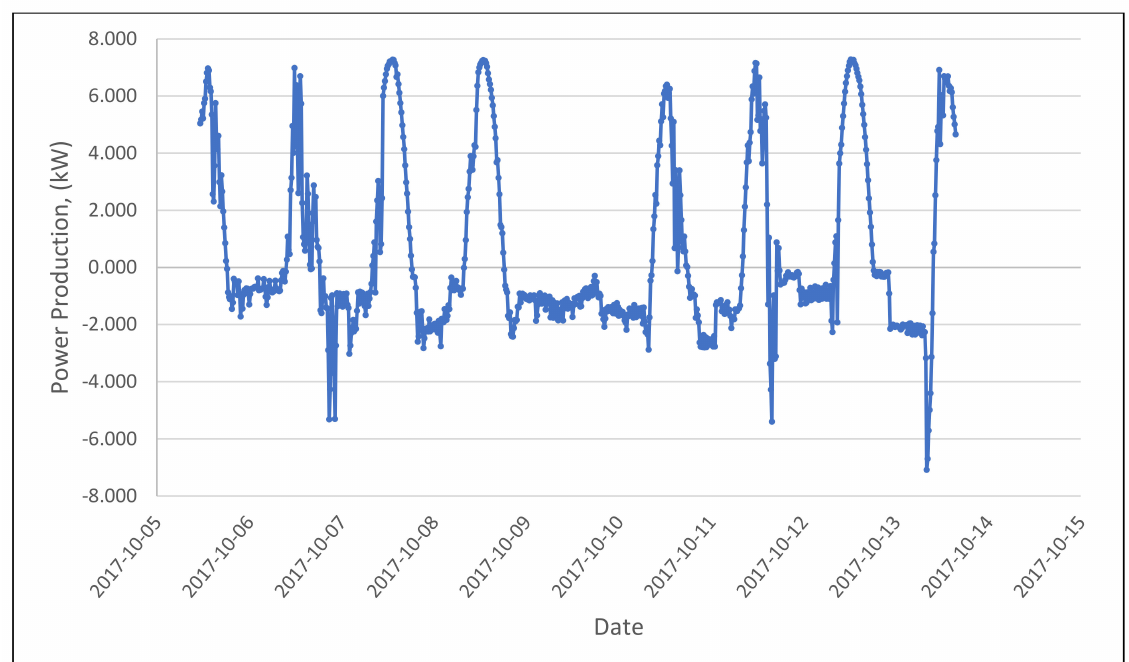
Figure 10. Measured PV energy generated by the PV system at the site.